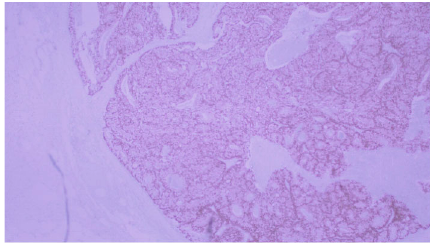
Figure 5: Strong nuclear CDX2 positive staining in the tumor (100 × ).